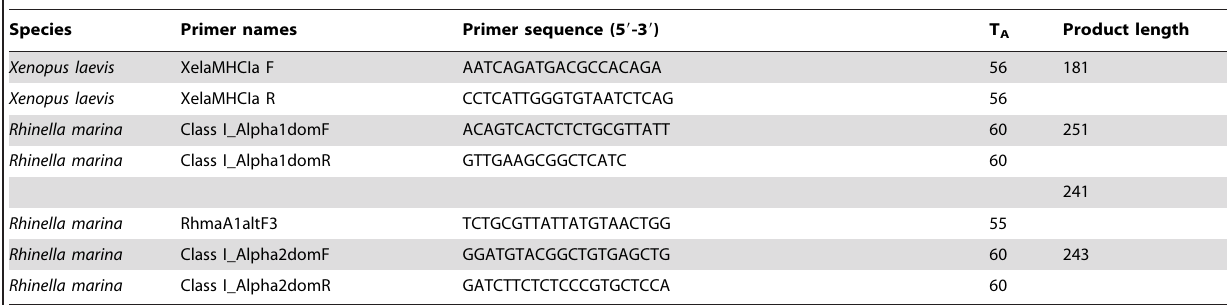
Table 1. PCR primers.